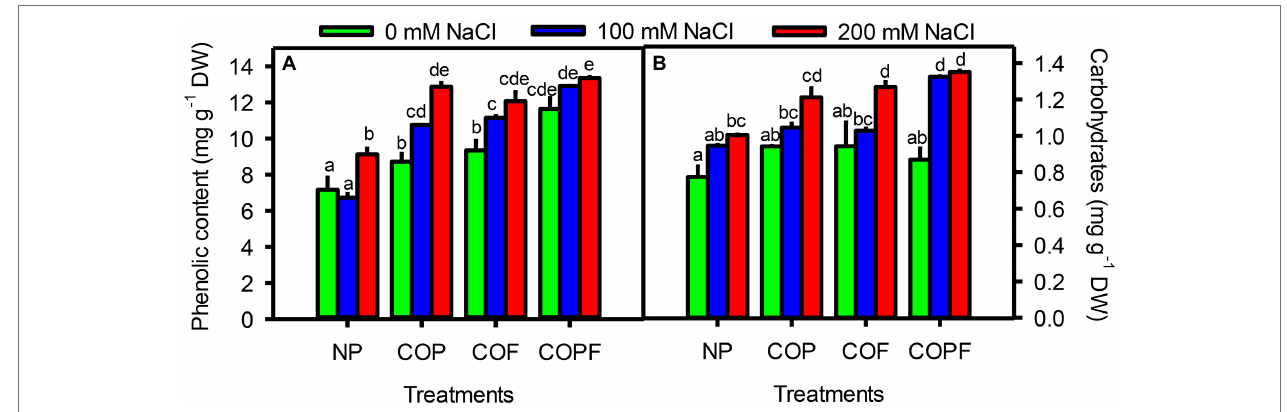
FIGURE 4 | Effect of salinity and coumarin applications on Phenolic contents (A) , Carbohydrate contents (B) . Plants were treated with 0 mg L − 1 coumarin (NP), 100 mg L − 1 coumarin as seed priming (COP), 100 mg L − 1 coumarin as foliar application (COF) and combined treatment (COPF), under 0, 100 and 200 mM NaCl. Values are represented as means ±SE (n = 3). Different letters represent significant differences ( p < 0.05) by Tukey’s HSD test.